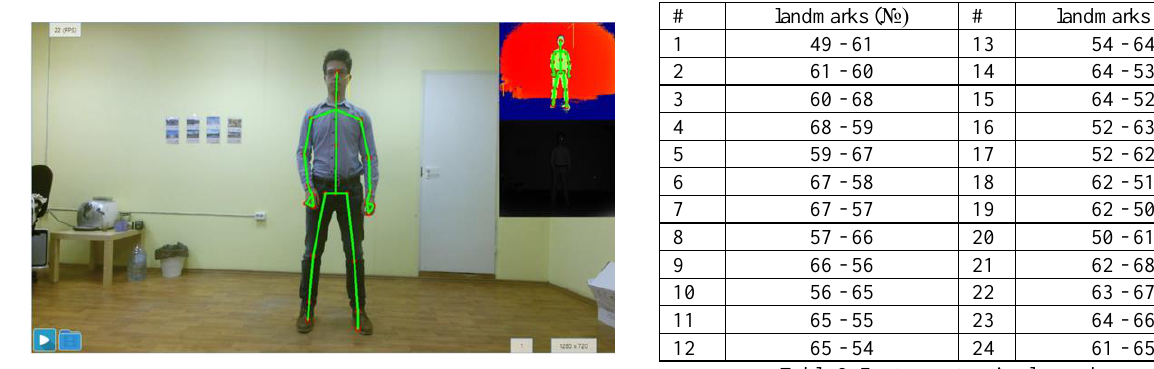
Figure 2. 25 key landmarks of Kinect 2.0 human skeleton model